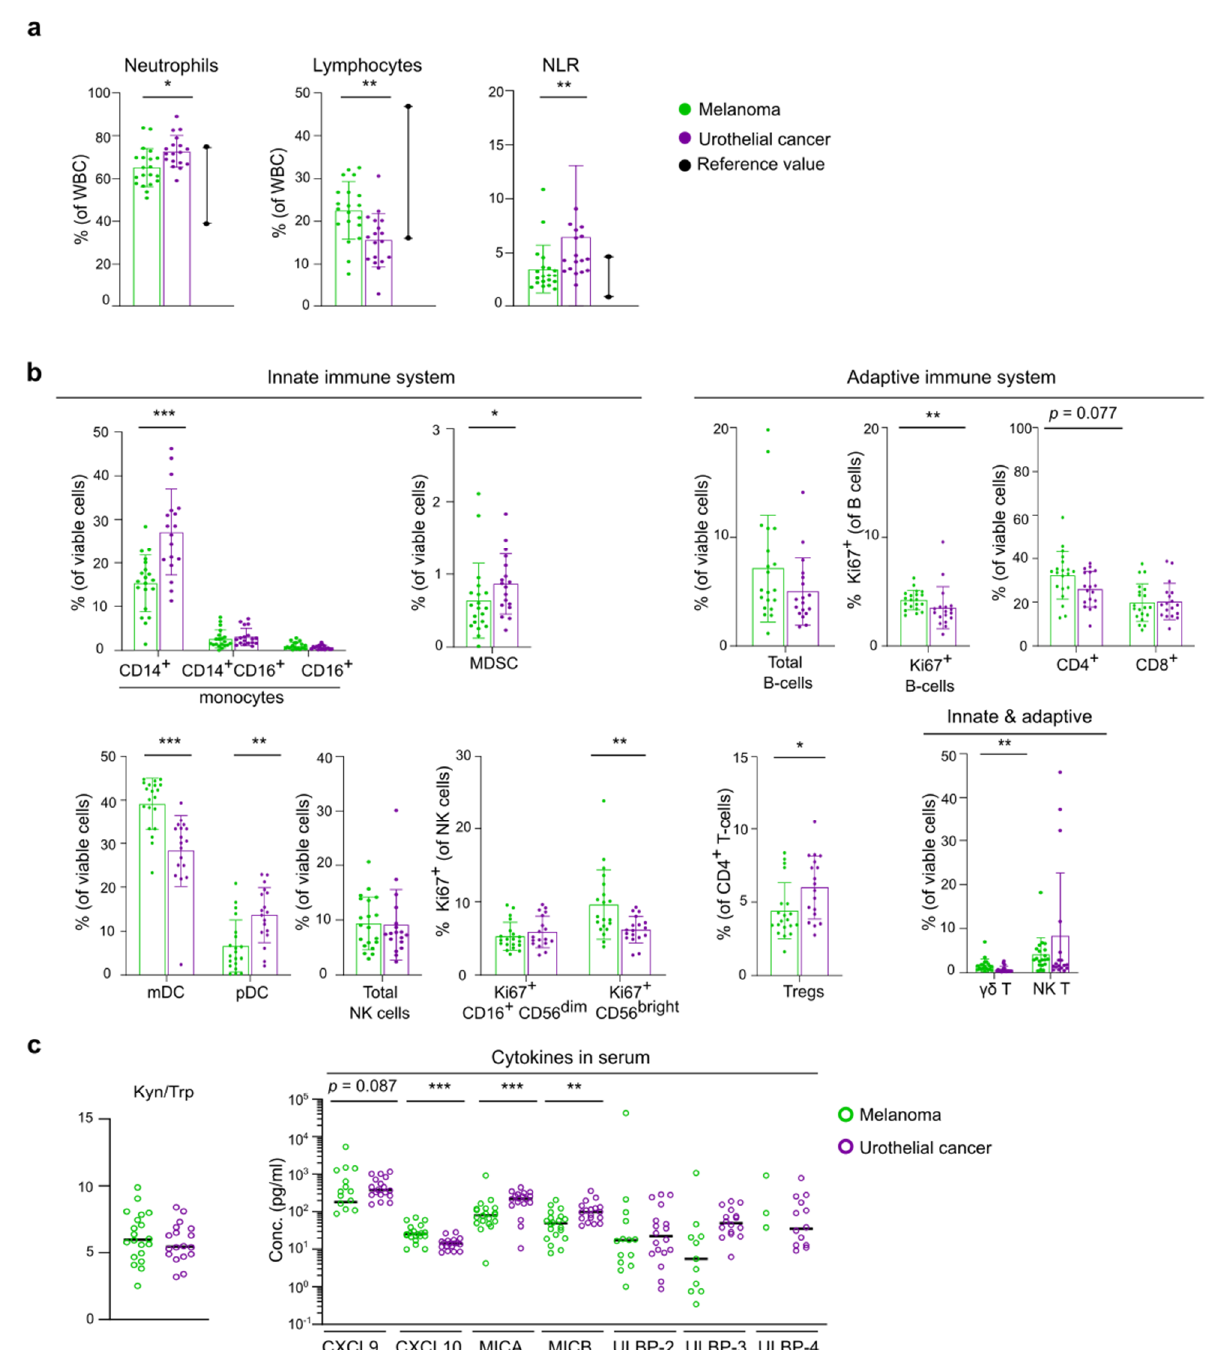
Figure 2. Baseline systemic immunity differs between melanoma and urothelial cancer. ( a ) Frequency of neutrophils, lymphocytes and neutrophil-to-lymphocyte ratio in melanoma and UC. Reference values are depicted in black. ( b ) Frequency of immune cell populations of innate and adaptive immune system. Error bar denotes ± SD. ( c ) (left) Ratio of serum concentrations of kynurenine (Kyn) on tryptophan (Trp), presented values are Kyn/Trp x 100. (right) Serum concentrations of T-cell activating chemokines CXCL9 and CXCL10 and concentrations of ligands for NK cell activing receptor NKG2D: MICA, MICB, ULBP-2, ULBP-3 and ULBP-4. Concentrations out of the range of detection could not be depicted. p value calculated using two-sided Mann-Whitney U test. * p < 0.05, ** p < 0.01, *** p < 0.001. WBC, white blood cells; MDSC, myeloid-derived suppressor cells; mDC, myeloid dendritic cells; pDC, plasmacytoid dendritic cells; Tregs, regulatory T-cells; ND, not detectable.